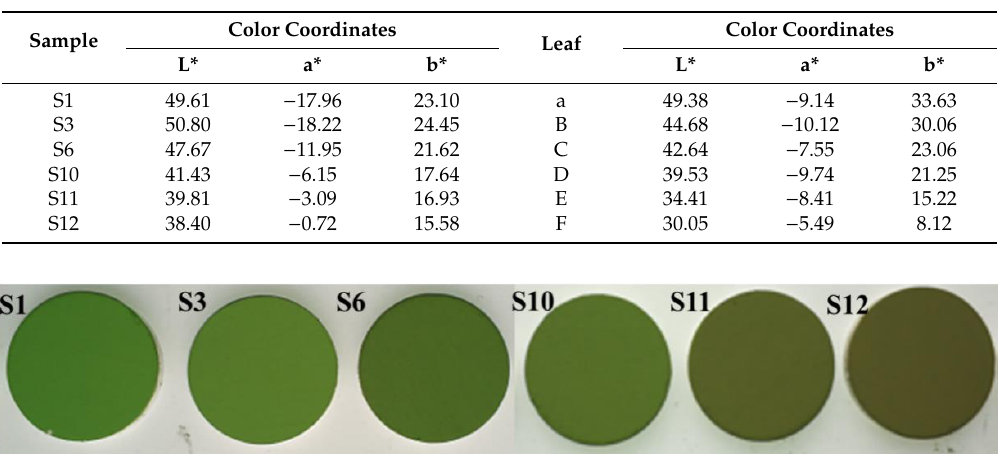
Table 2. L*, a*, and b* values of Cr 2 O 3 samples and Ficus microcarpa leaves.